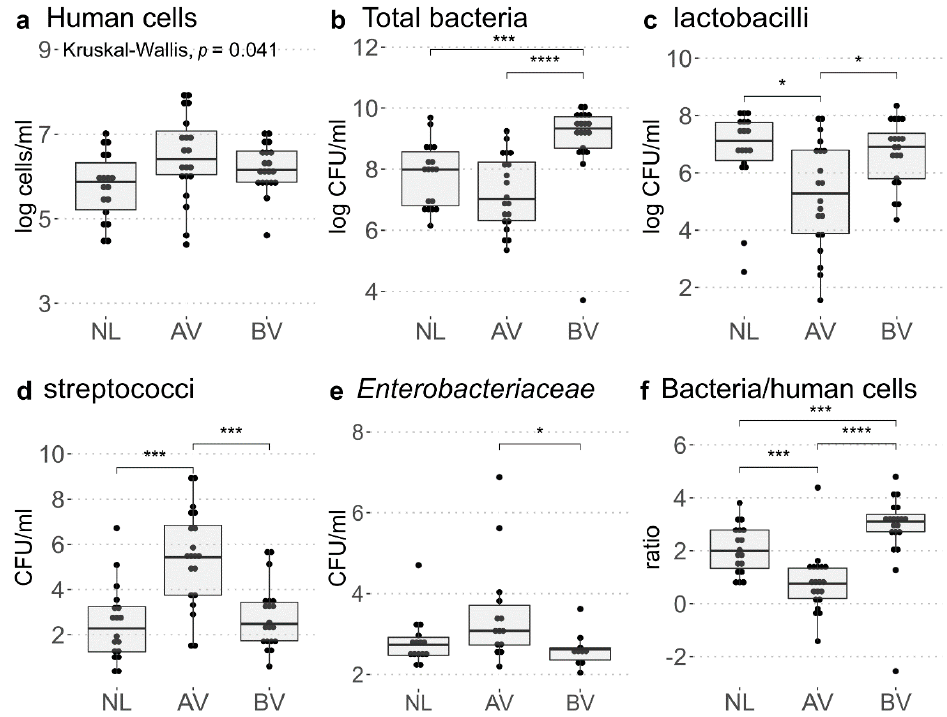
Figure 3. Estimated human cell ( a ) and bacterial concentrations ( b – d ); ( a ) Concentration of human cells, estimated by qPCR of the cyc1 gene. A Kruskal-Wallis test indicated significant differences between the groups ( p = 0.041), but this was not confirmed by pairwise Wilcoxon tests. ( b ) Total bacterial concentration estimated by qPCR with general primers for the V4 region of the 16S rRNA gene. ( c ) Concentration of lactobacilli, ( d ) streptococci, and ( e ) Enterobacteriaceae , estimated by qPCR with genus-specific primers. ( f ) Ratio of bacteria to human cells as an estimator for bacterial load. For each gene, a standard curve was used to calculate CFUs or cell concentrations, as indicated in Materials and Methods and Supplementary Figures. The significance levels from Wilcoxon and Kruskal-Wallis tests indicated in the graphs correspond to ns: p > 0.05, *: p < 0.05, **: p < 0.01, ***: p < 0.001, ****: p < 0.0001.